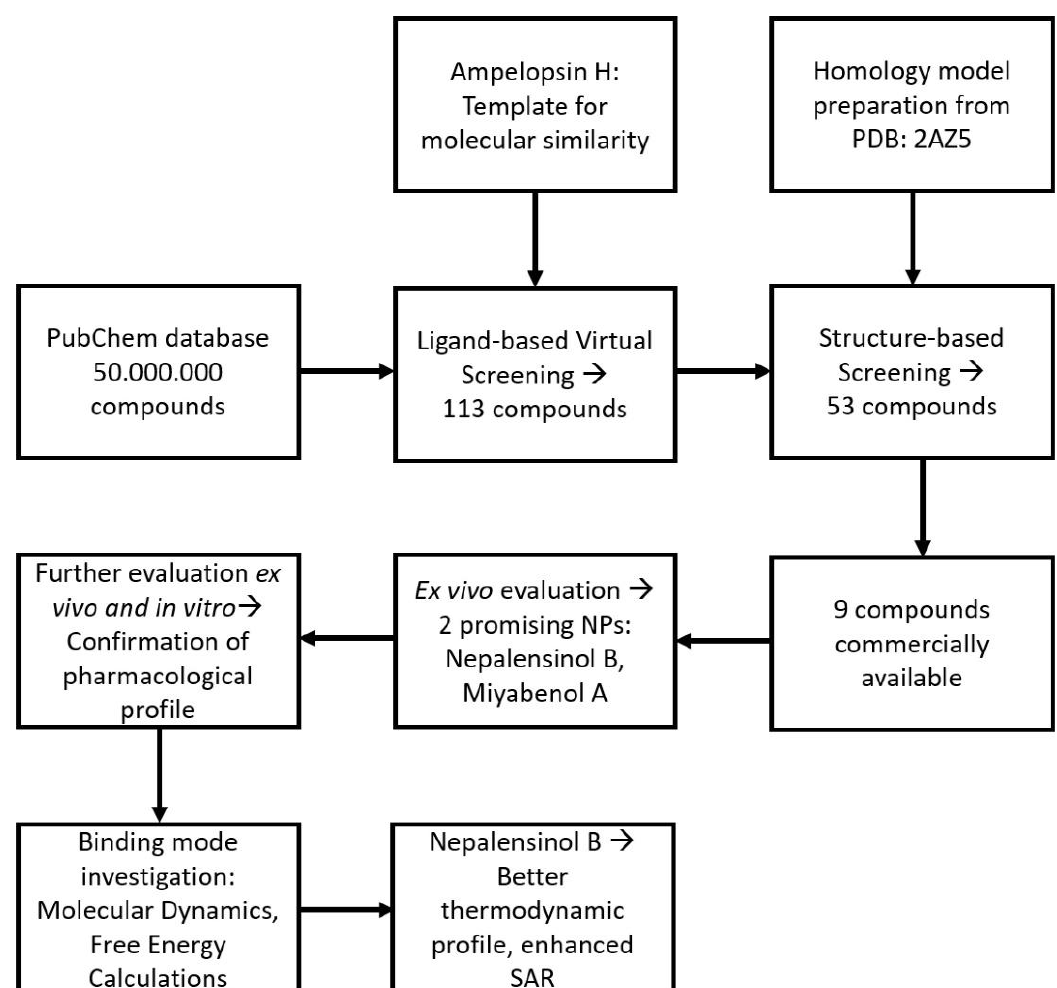
Figure 3. Schematic representation of the experimental workflow, containing a combination of pharmacological studies with computational models. The workflow starts by applying a molecular similarity search in PubChem, which yields 113 compounds. These compounds are further refined via a docking process in a homology model based on PDB: 2AZ5 (TNF dimer complex with ligand SPD304), resulting in 53 candidate ligands with a prospective affinity. Out of these compounds, 9 were commercially available, and thus they were acquired and further tested. An initial ex vivo screening in L929 cells verified that 2 compounds exhibit promising potency. Their optimal pharmacological profile was affirmed by further ex vivo testing in primary murine joints’ SFs and in vitro testing, evaluating the potential of the compounds to interrupt TNF binding to its main receptor, TNFR1. To investigate the compounds’ binding mode, a set of molecular dynamics simulations and free energy calculations was performed, suggesting that one of the two compounds, Nepalensinol B, could better serve as a candidate lead structure for anti-TNF drug